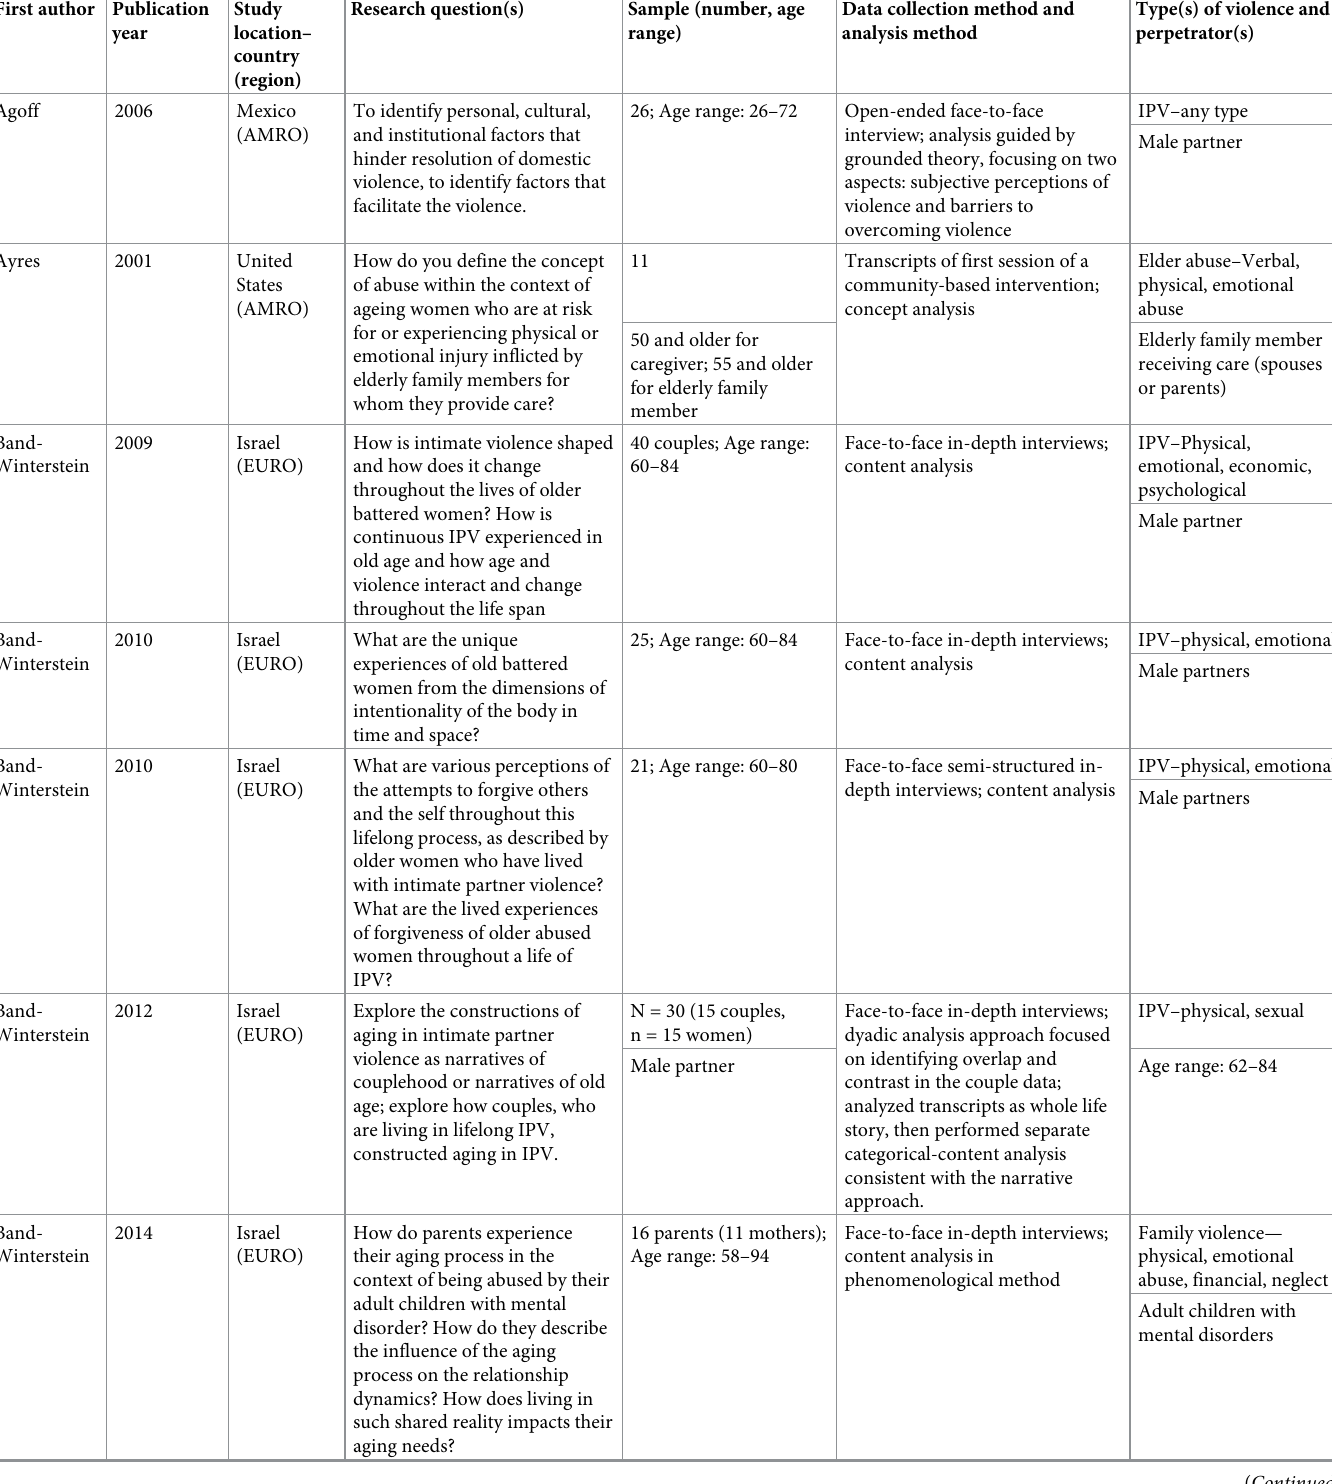
Table 1. Characteristics of included